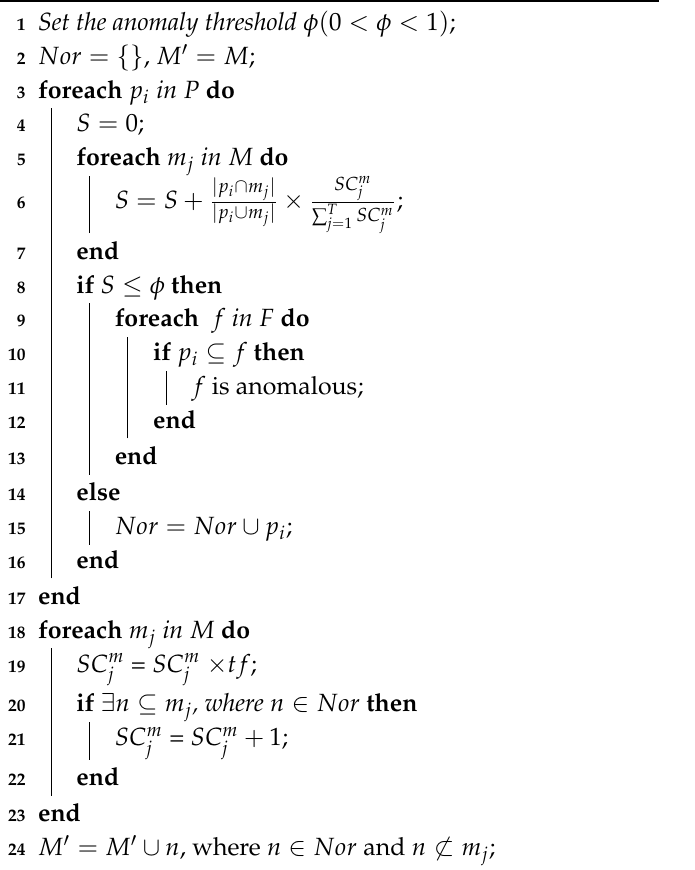
Algorithm 3: Anomaly detection and model